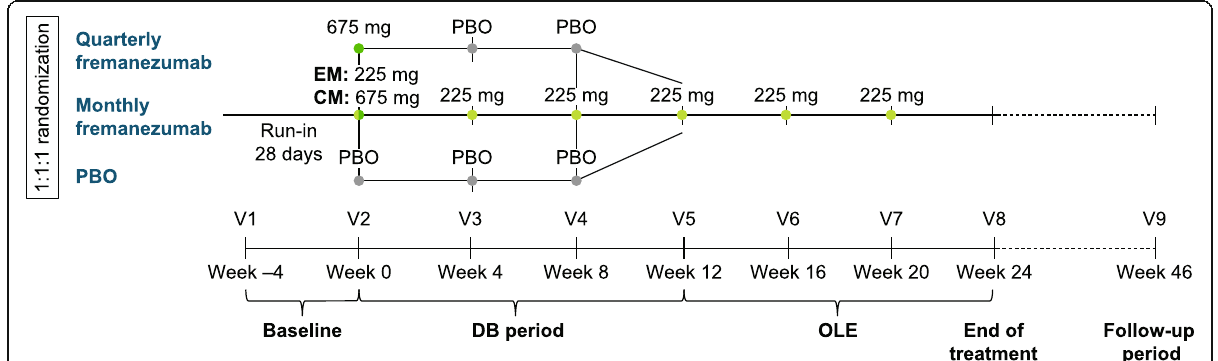
Fig. 1 FOCUS study design. PBO, placebo; EM, episodic migraine; CM, chronic migraine; V, visit; DB, double-blind; OLE, open-label